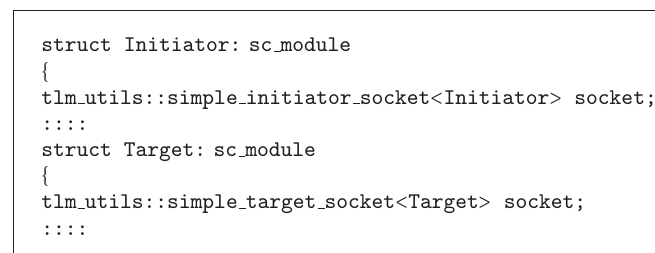
Figure 8: SoLO bootloader fault injection